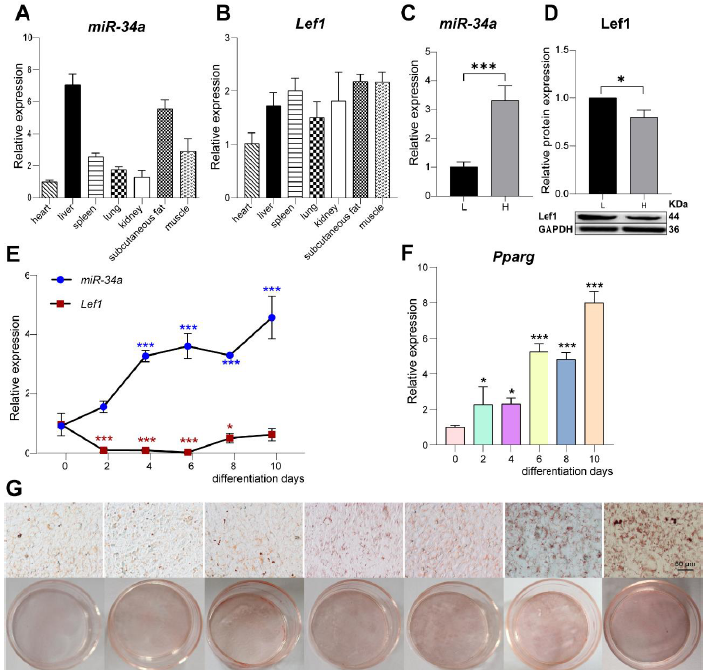
Figure 4. The expression pattern of miR-34a and Lef1 in different tissues and the differential process of 3T3-L1-derived adipocytes. miR-34a are highly expressed in liver, backfat, and muscle ( A ), and Lef1 was highly expressed in spleen, backfat and muscle ( B ). qPCR indicated miR-34a expression was higher in high IMF-content muscle ( C ), while Lef1 protein was lower in high IMF-content muscle detected using Western blot ( D ). The expression of miR-34a was gradually increased with the differentiation of 3T3-L1-derived adipocytes, while Lef1 was decreased ( n = 4) ( E ). The expression of Pparg G ( n = 4) and lipid droplet accumulation were gradually increased during the differentiation of 3T3-L1 cells ( F , G ). The expression of genes or proteins were normalized to the corresponding housekeeping gene or protein (β -actin and U6 for qPCR and GAPDH for Western blot). * p < 0.05, *** p < 0.001 versus Control.